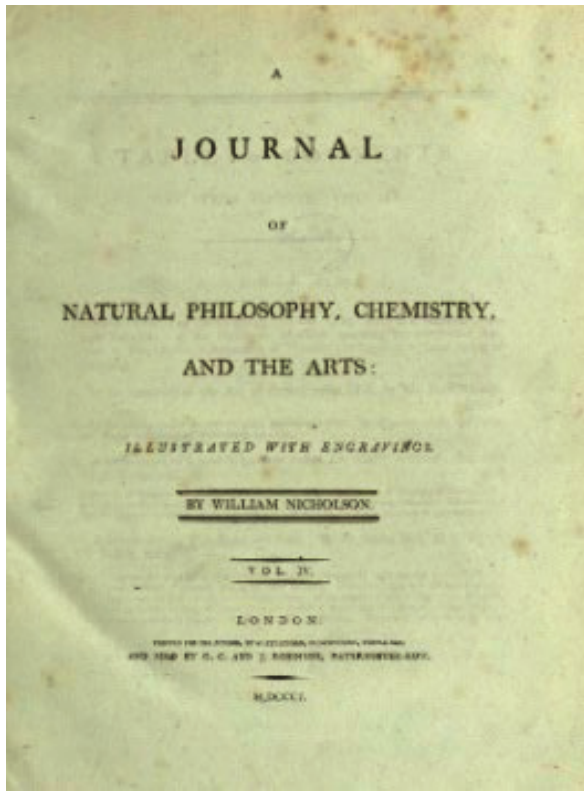
Figure 1. Title page of the remarkable Volume IV of Journal of Nat- ural Philosophy, Chemistry and the Arts , called Nicholson’s Journal . In this Volume from 1801, in the six issues from July to December 1800 the notable number of 13 papers (out of a total of 58) were published which exclusively dealt with galvanic